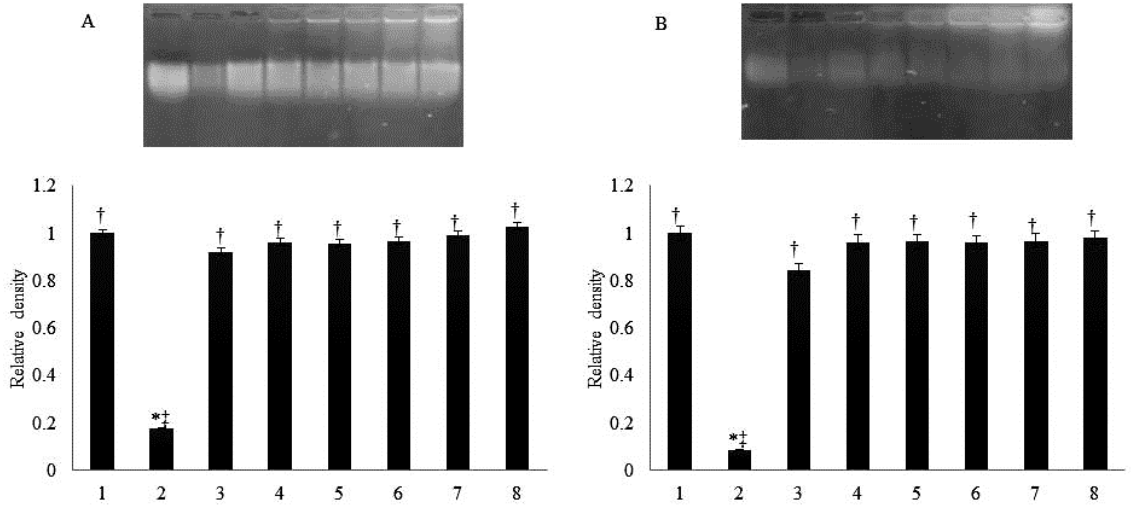
Figure 3. Protective potential of Lunaria annua aerial part (A) and root (B) extracts against peroxyl radical-induced DNA damage. Untreated DNA (lane 1, negative control), damaged DNA (lane 2, positive control), quercetin (lane 3, 100 µg/mL, standard), L. annua extracts at the concentrations of 25, 50, 100, 200, and 400 µg/mL (lanes 4-8). * p < 0.05 when compared with the negative control group; † p < 0.05 when compared with the positive control group, ‡ p < 0.05 when compared with the reference